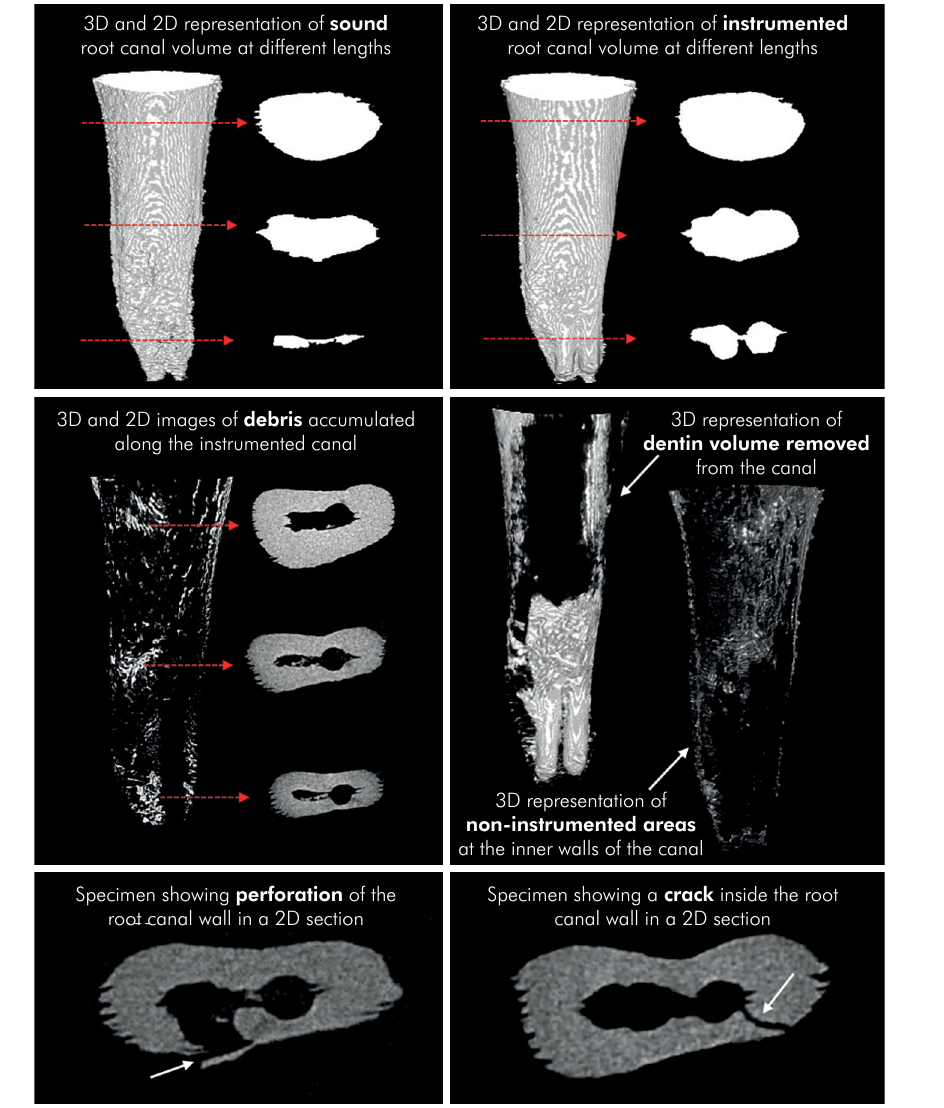
Figure 2. Representative 2D and 3D images of sound and instrumented canals, mechanical outcomes (accumulated hard tissue debris, removed root material volume, and non-instrumented areas) and the type of defects evaluated in the present